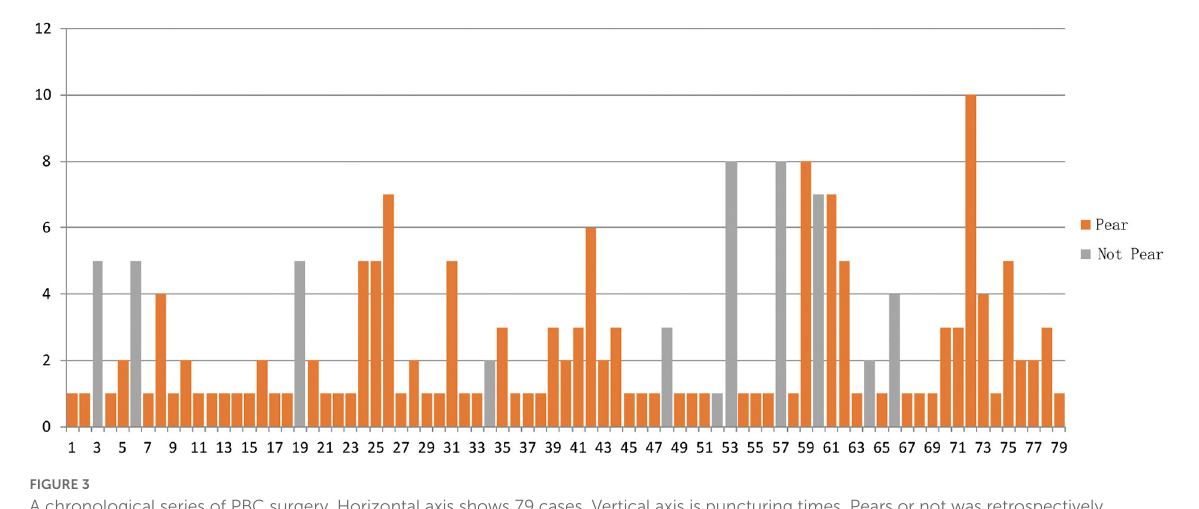
FIGURE3 A chronological series of PBC surgery. Horizontal axis shows 79 cases. Vertical axis is puncturing times. Pears or not was retrospectively analyzed, so there was case only got once puncture, but not pears (52).